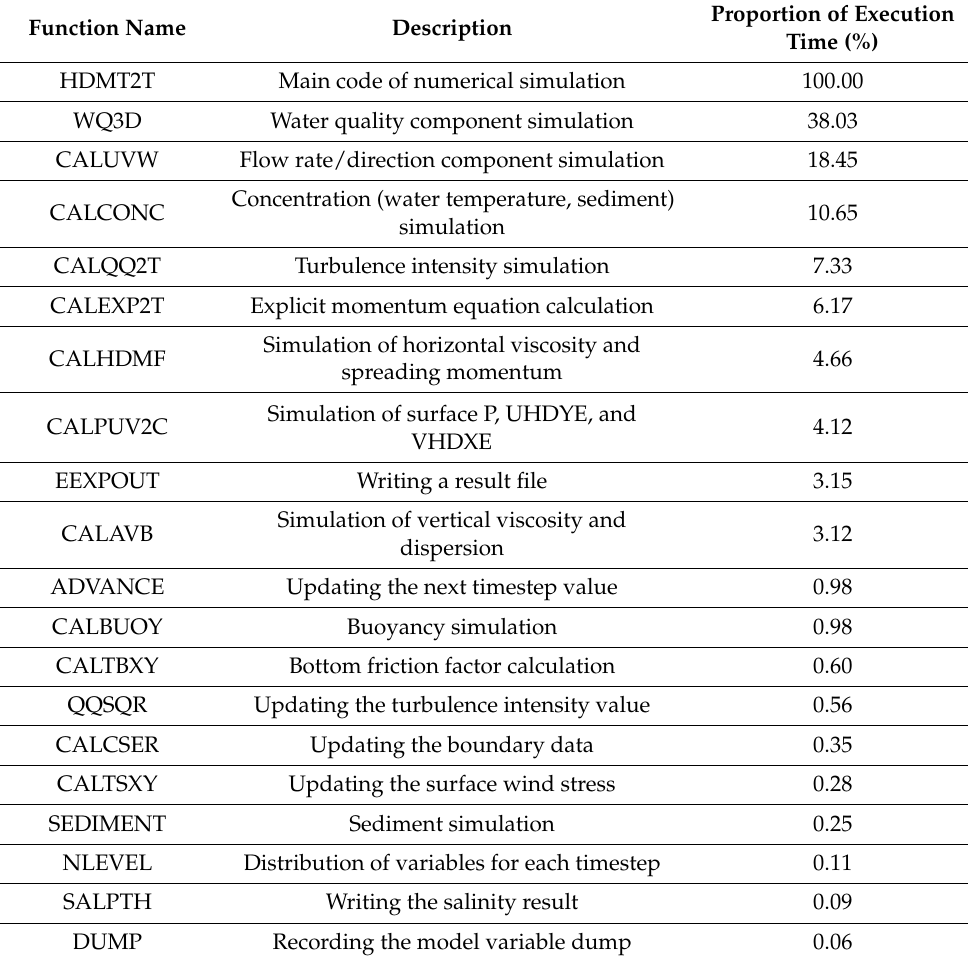
Table 4. Hotspot analysis results for the EFDC-NIER